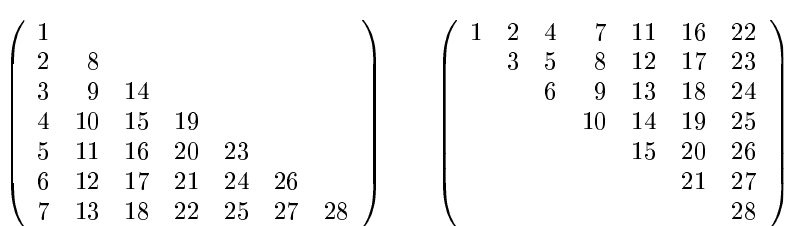
Figure2.Themappingof7(cid:2)7matrixfortheLAPACKCholeskyAlgorithmusingthe